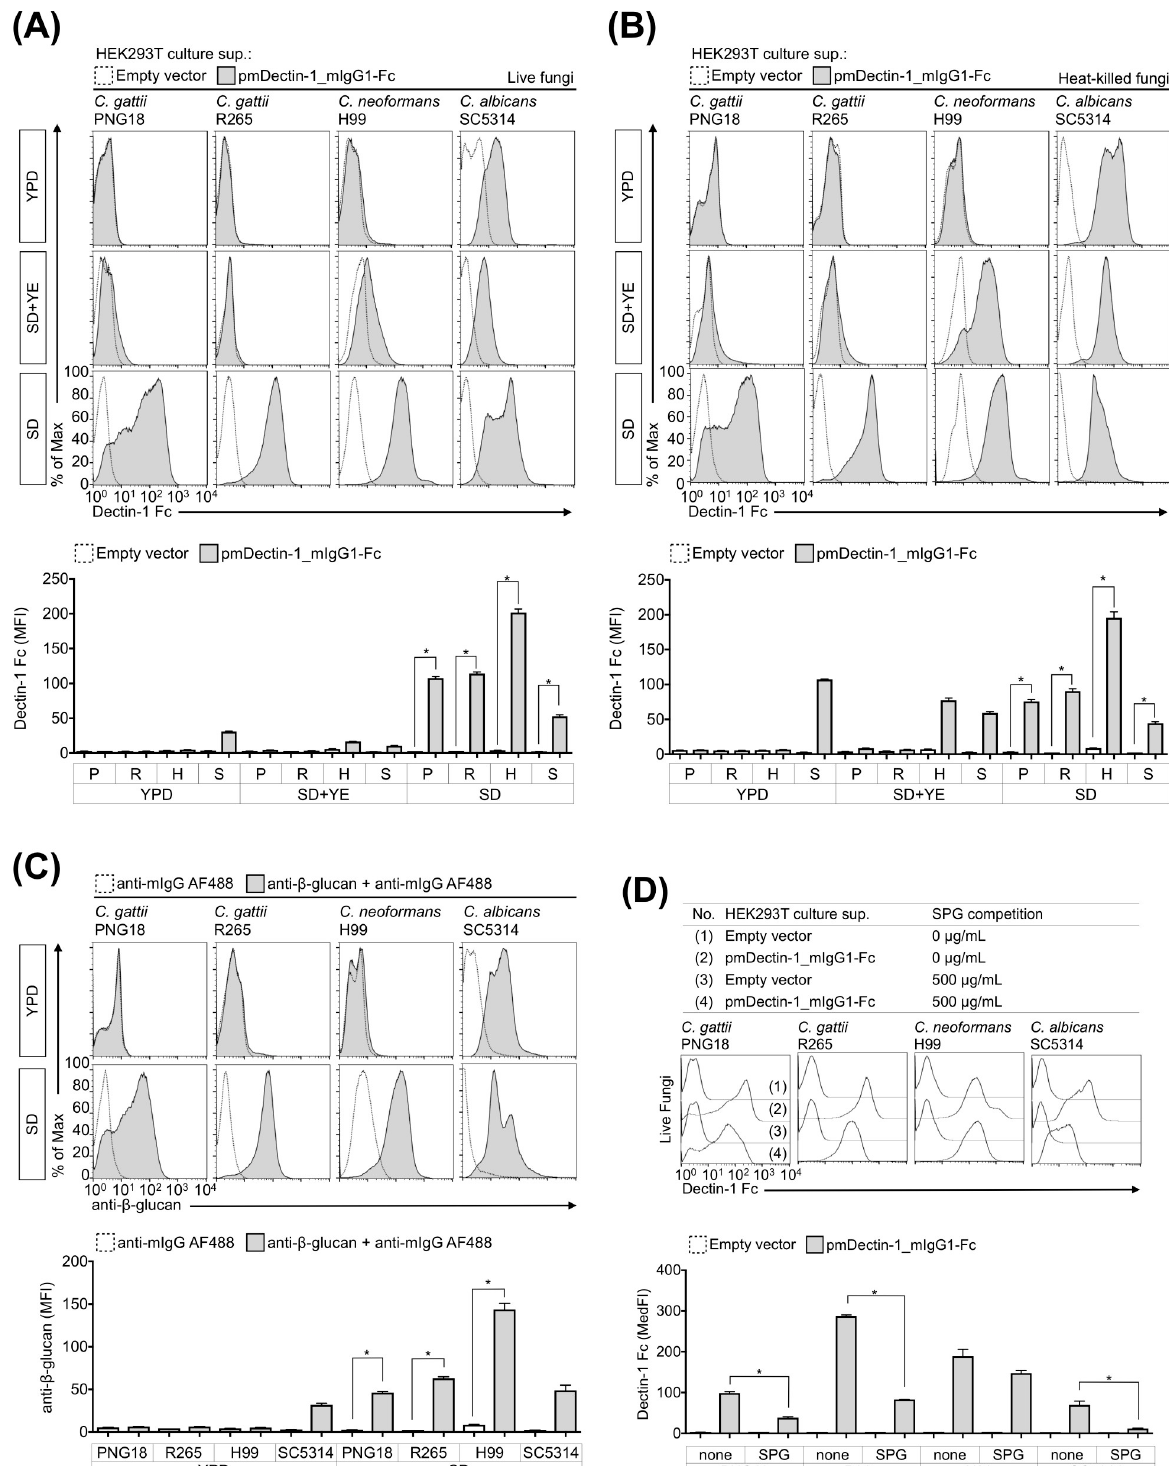
Fig 1. SD medium induces dectin-1 ligands on cryptococcal cells. Deposition of Fc dectin-1 was measured on live fungal cells (A and D) and heat-killed fungal cells via flow cytometry (B). In a similar manner, β -glucan exposure on heat-killed fungal cells was evaluated using anti- β - 1,3-glucan mAb (C). The flow cytometry profile and bar graphs of the mean fluorescence intensity (MFI) or median fluorescence intensity (MedFI) are depicted. Representative data (mean ± SDs) from three independent experiments are shown. � : P < 0.05 as determined via an unpaired t -test, P: C . gattii PNG18, R: C . gattii R265, H: C . neoformans H99, S: C . albicans SC5314.